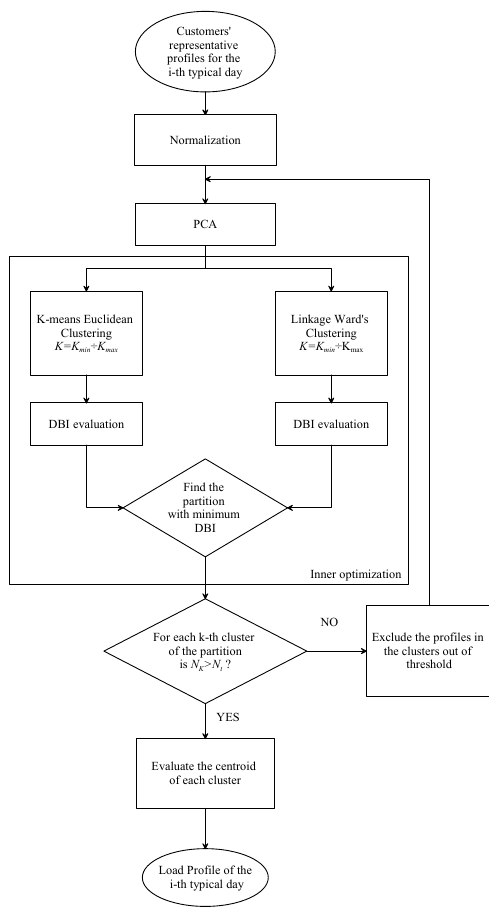
Figure 5. Flow chart of the second stage of clustering: inner